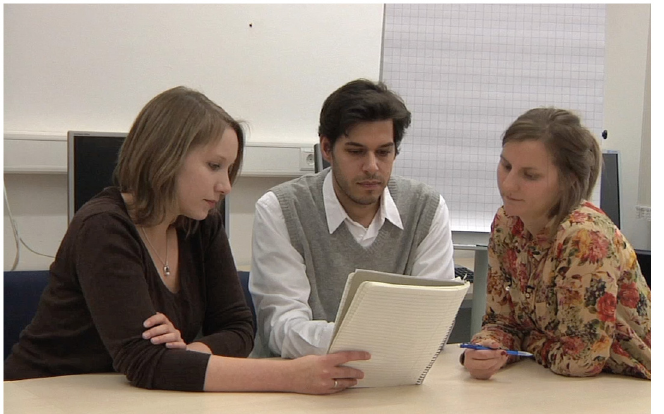
Fig 2. Example of stimuli picture used in Study